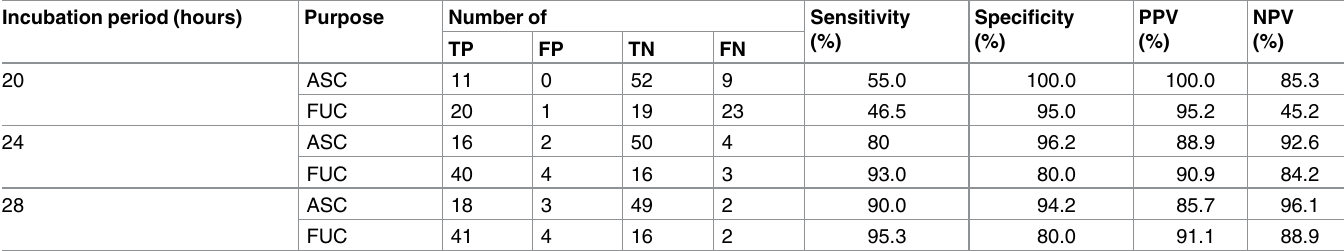
Table 2. Assessment of the selectiveBEAV broth plus MALDI-TOF MS (SBEAVM) method for the detection of VRE in selected patients. Incubation period